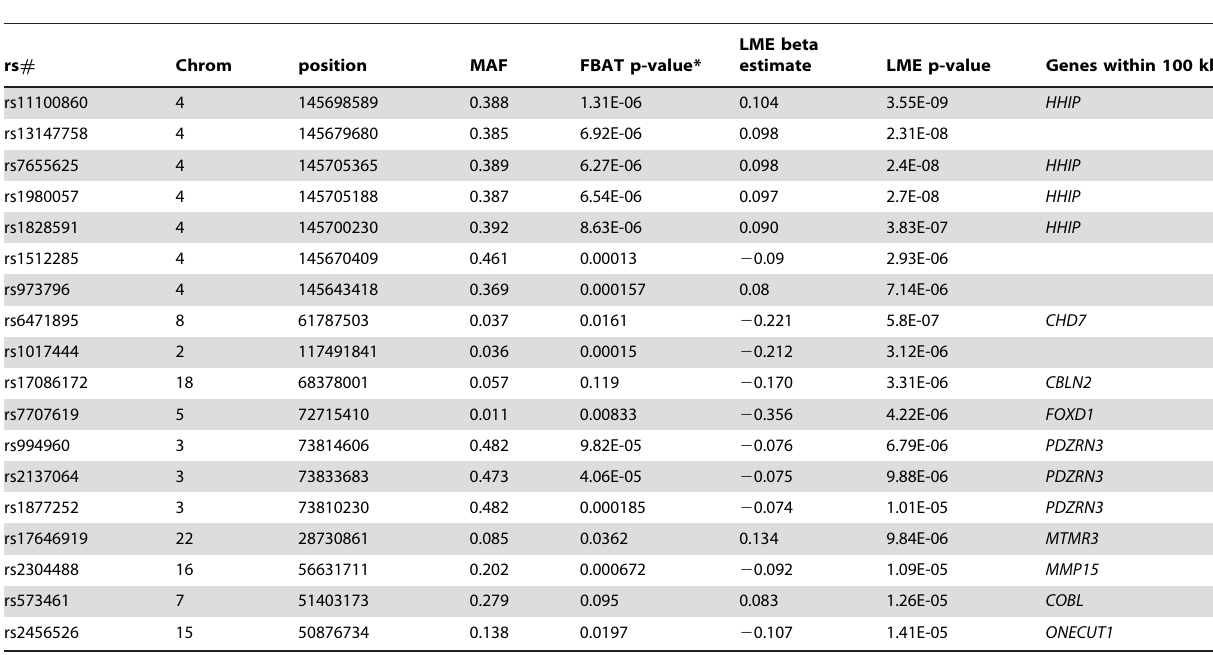
Table 2. Top 10 regions implicated by LME results for percent predicted FEV 1 /FVC in an additive genetic model studying genotyped SNPs in the Framingham Heart